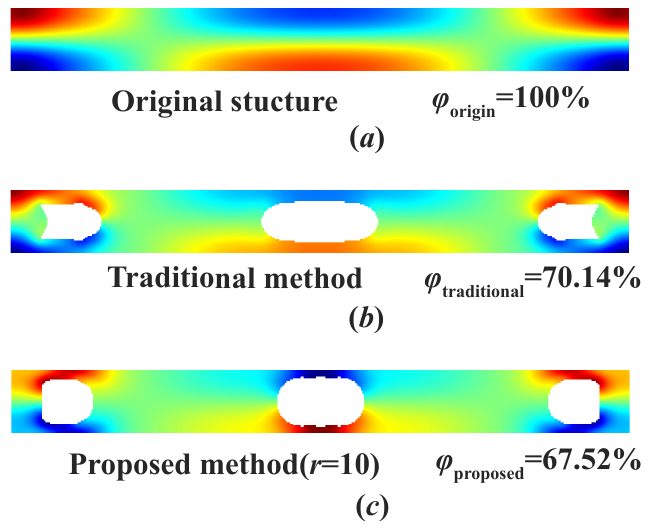
Figure 5. Topology optimization results for a clamped-clamped microbeam resonator. ( a ) The original structure. ( b ) The optimization result where the traditional subspace method is implemented in the finite element analysis step. ( c ) The optimization result where the proposed method is implemented in the finite element analysis